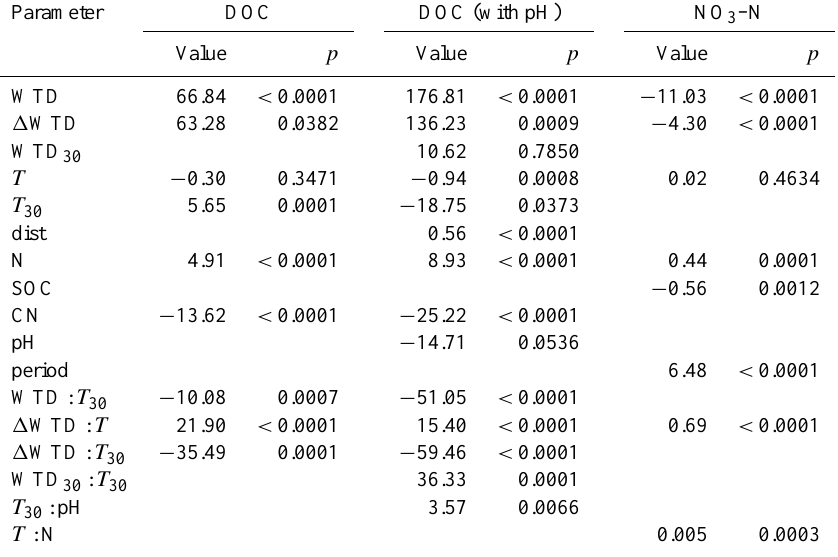
Table 5. Coefficients of the GLS (DOC) and LME (NO 3 –N) model for the DOC and the NO 3 –N concentrations in the groundwater samples. WTD – water table depth; 1 WTD – change of the WTD within the last week; WTD 30 – average WTD of the last 30 days; T – air temperature; T 30 – average air temperature of the last 30 days; dist – distance to the drainage ditch; N – nitrogen content of the topsoil; SOC – soil organic carbon content of the topsoil; CN – C:N ratio of the topsoil; period – wet or dry